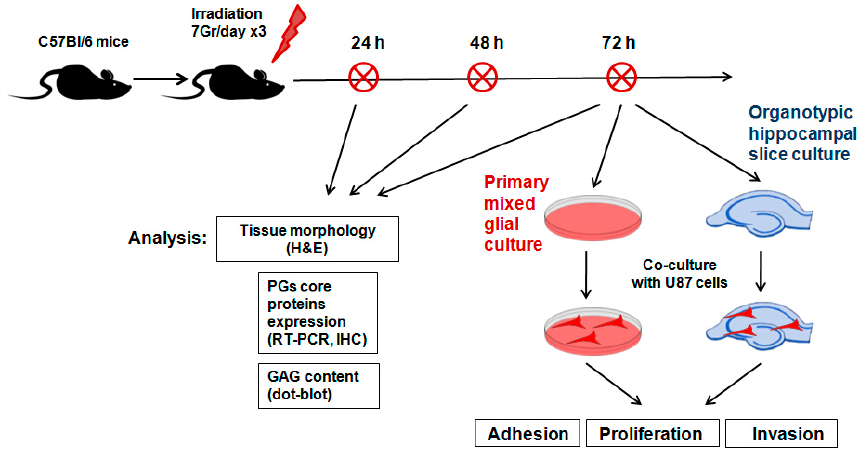
Figure 1. Scheme of the experiment on triple irradiation of mouse brain.